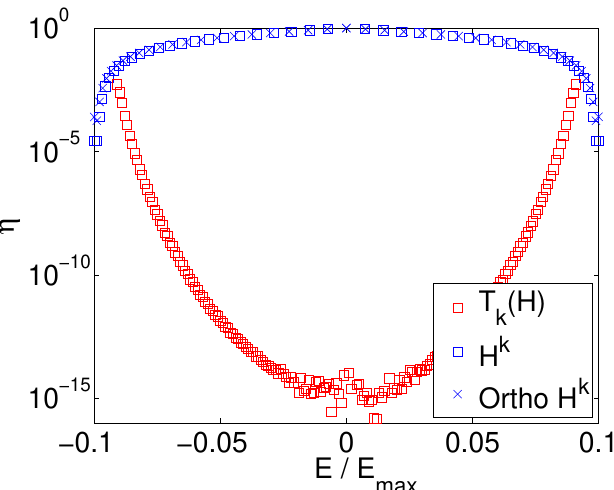
Figure 8: Comparison of relative error distributions η ( E ) for different basis during the second step of the DACP method, including { T (cid:8) (cid:9) H k squares) and with Schmidt orthogonalization (blue